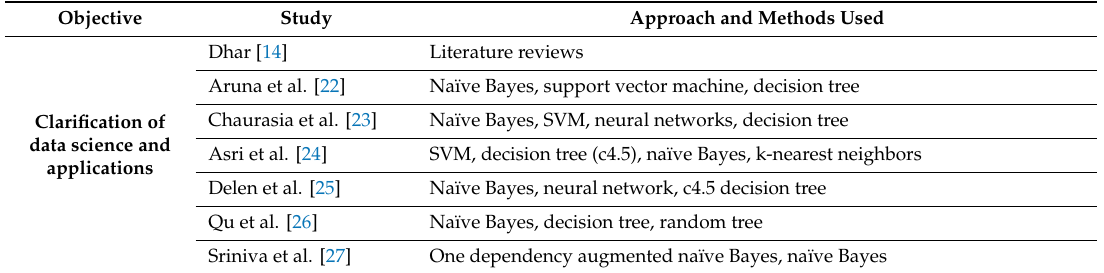
Table 1. Recent Related